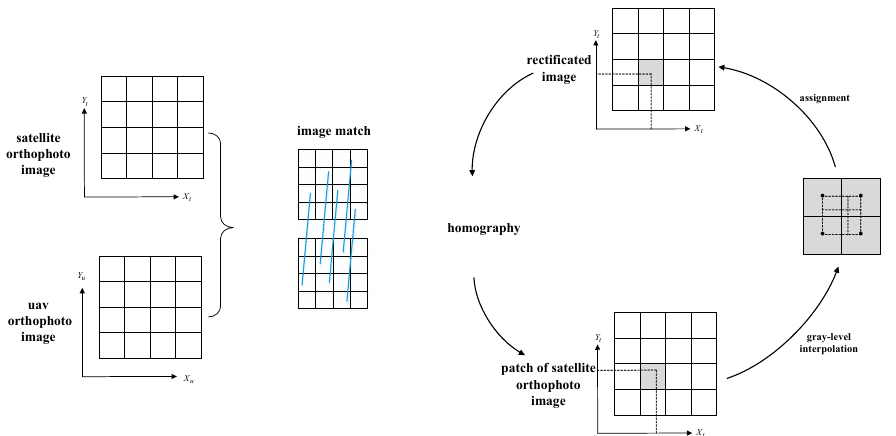
Figure 6. The correction process for the satellite orthophoto images.